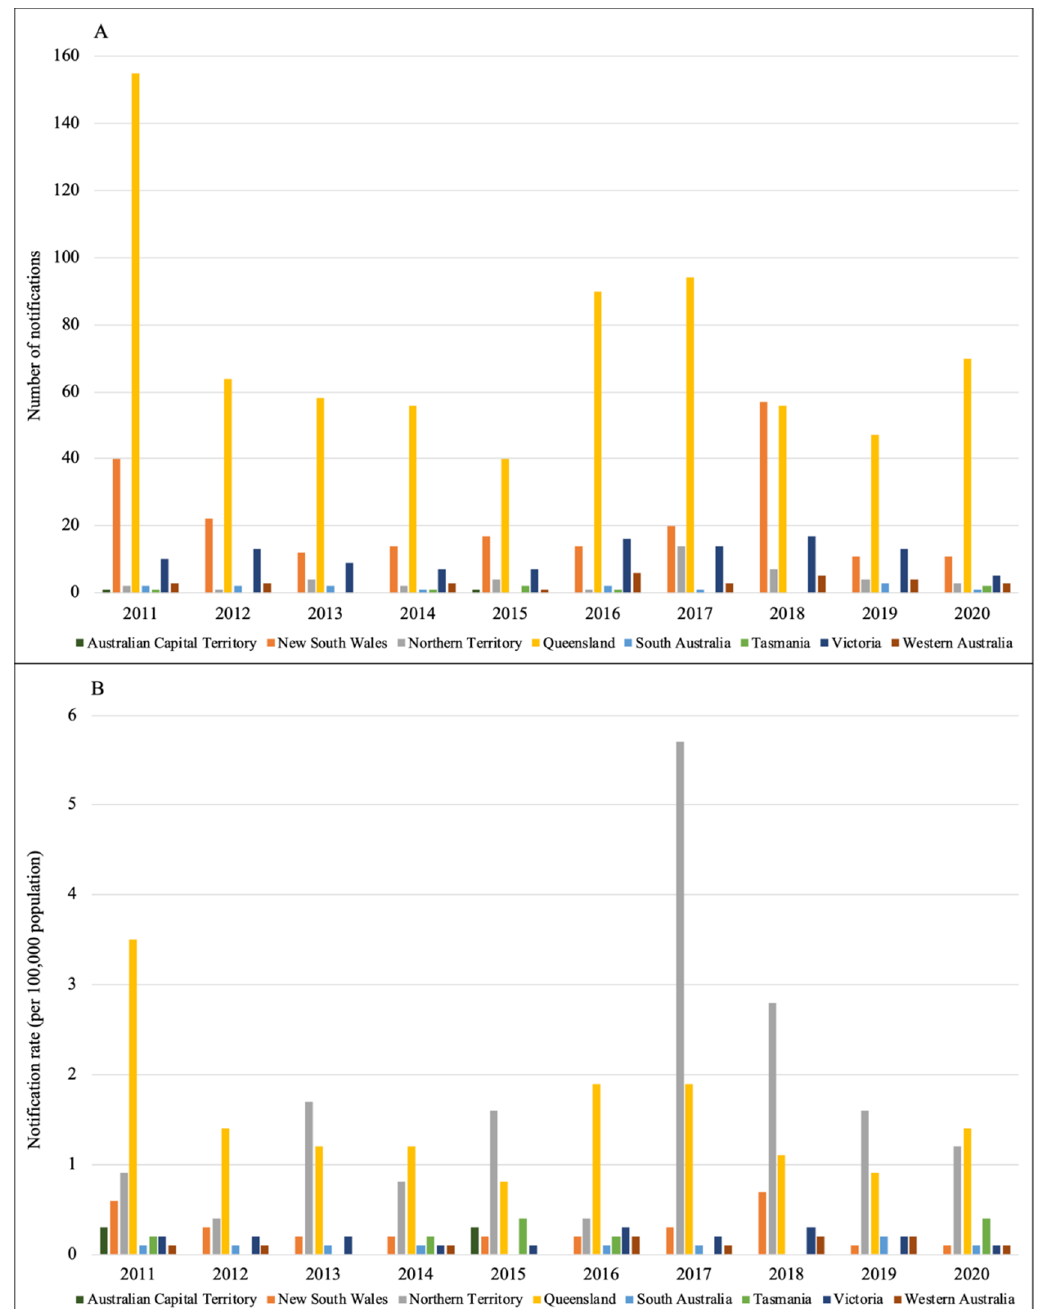
Figure 1. Incidence of leptospirosis notified to the NNDSS by Australian states and territories from 2011 to 2020. ( A ) number of notifications; ( B ) notification rate (per 100,000 population) [17].